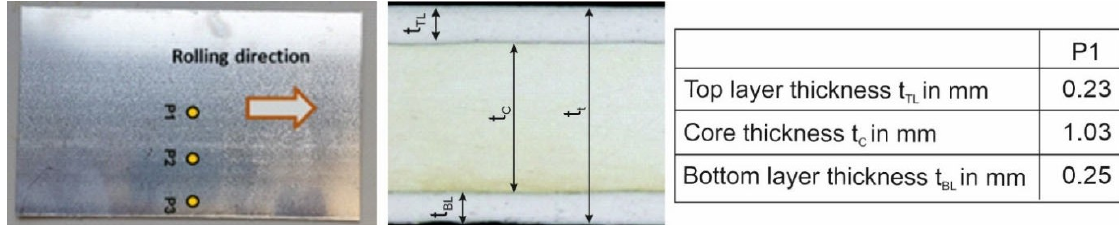
Figure 4. Cladding Result: overview, microscopic photograph and measurements.